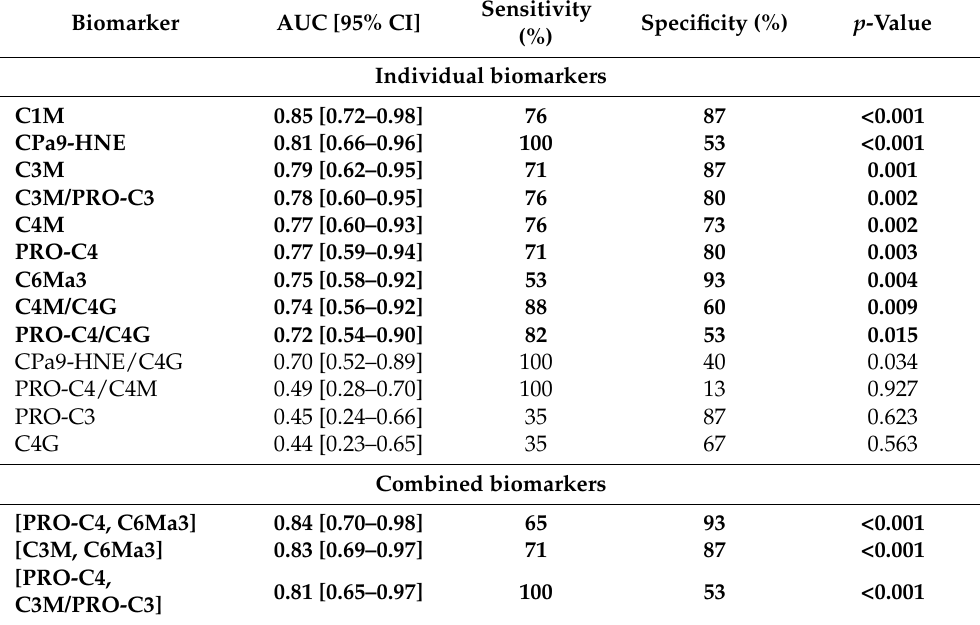
Table 3. Receiver operating characteristics (ROC) analysis demonstrating the area under the curve (AUC) of each individual biomarker as well as a selected combination of biomarkers, representing their discriminative ability regarding long-term continuation vs. discontinuation of vedolizumab treatment. Biomarker AUC [95%